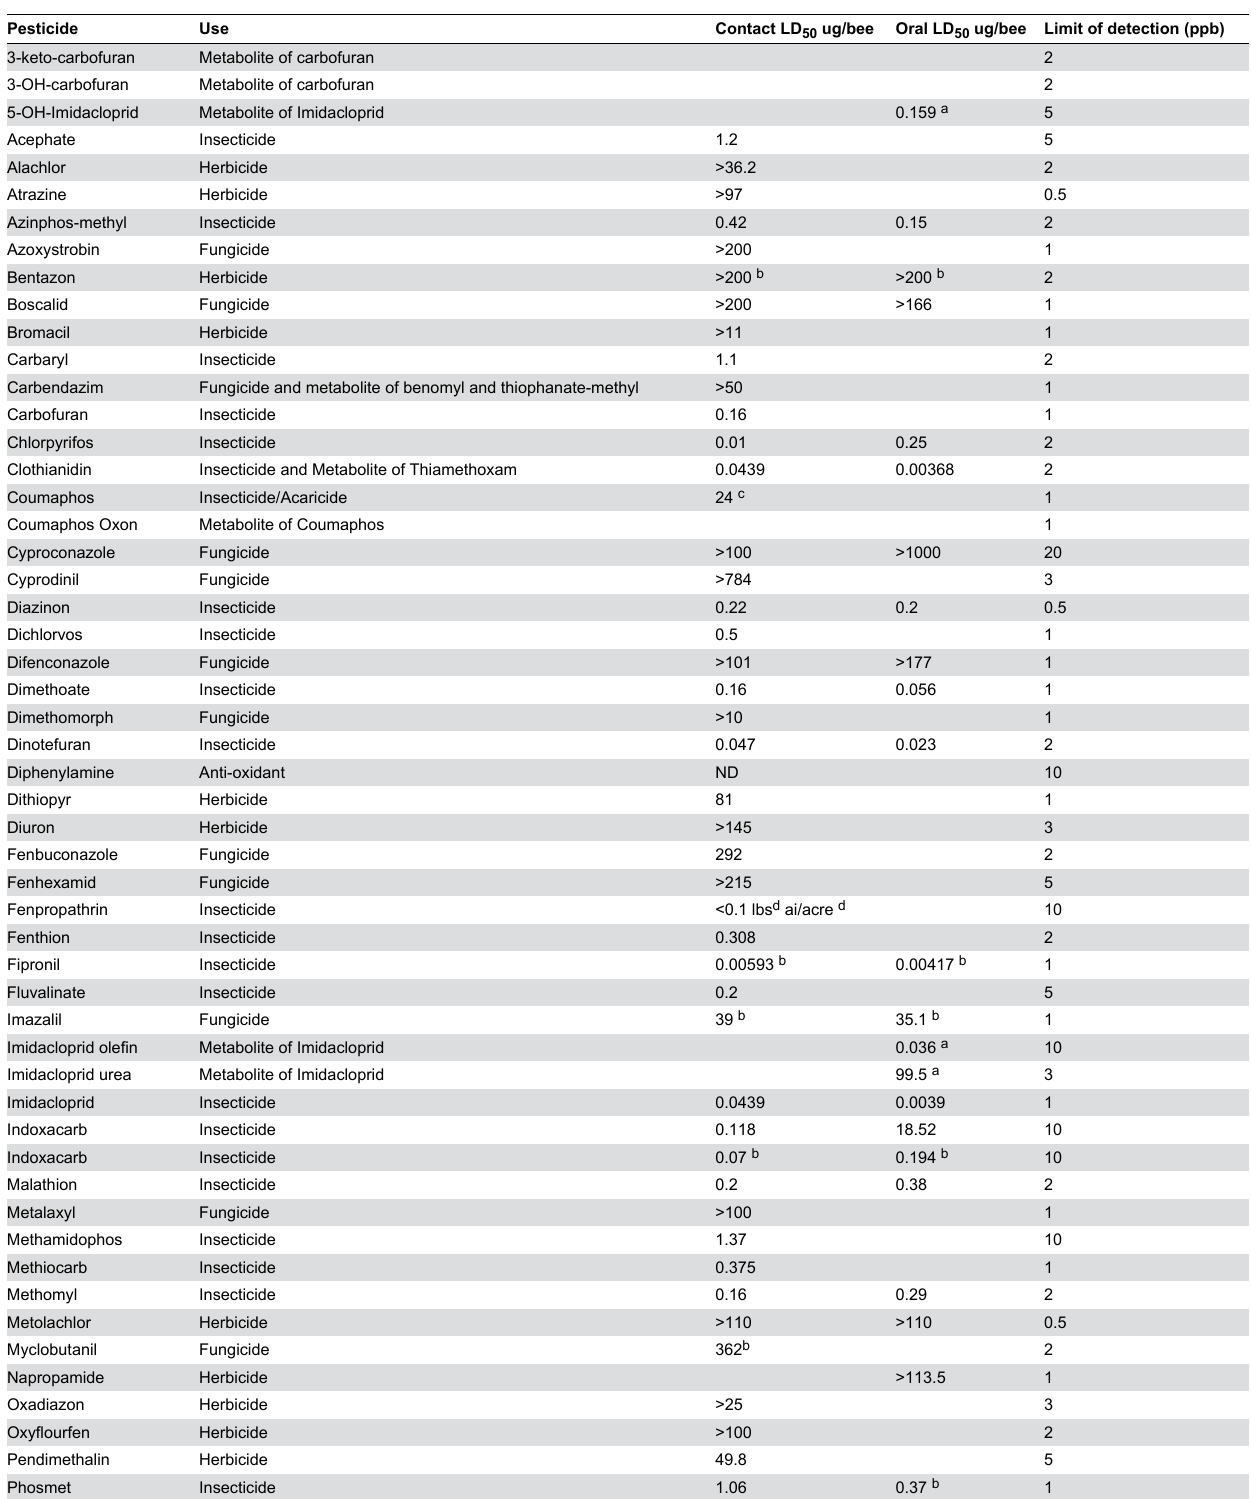
Table 1. Pesticides detected in pollen trapped by honey bee hives, with pesticide use and information on acute toxicity to adult worker honey